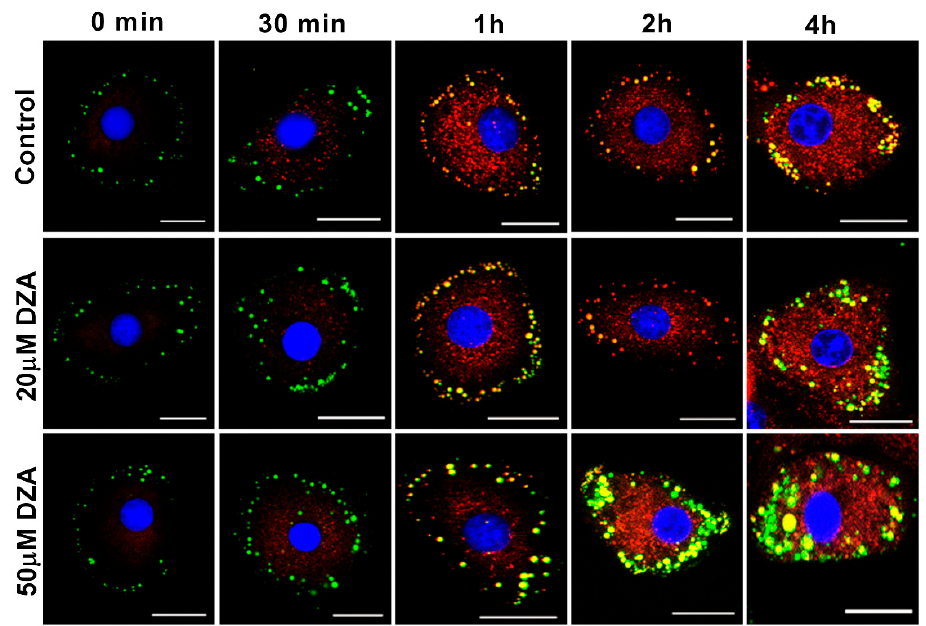
Figure 7. Time-bound studies depicting the effect of DZA on nascent and preformed LDs. Hepatocytes were incubated with 50 µmol/L OA media containing BODIPY FL C12 (green florescent fatty acid) overnight, followed by incubation with different concentrations (20 µm and 50 µm) of DZA treatment along with BODIPY 558/568 C12 (red fluorescent) for different time intervals. Control and DZA-treated cells were then fixed and mounted onto coverslips. Images of representative hepatocyte captured at 0 min, 30 min, 1, 2 and 4 h depicting fusion of nascent and preformed LDs in DZA-treated cells at increasing time intervals; scale bar 20 µm.